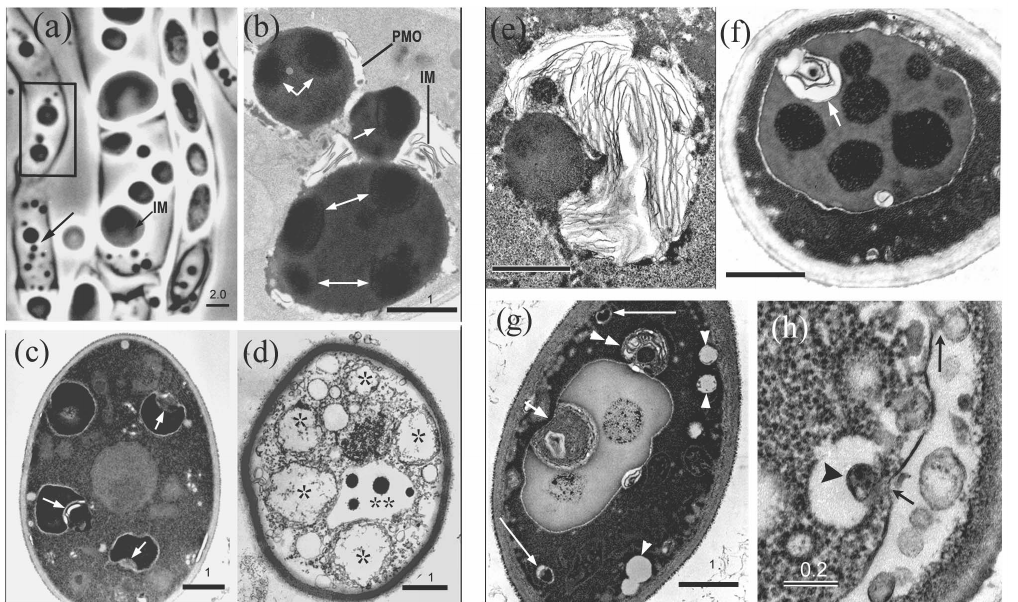
Figure 2. The A.pullulans promycosome organelle: light vs. electron microscopy. (a) Light microscopy; (b–h) electron microscopy. (a) The left hypha contains many presumptive budding PMOs (box and arrow), which express a lipoid body (arrow, center hypha) within the PMO inner membrane (IM). Walled endospores (right hypha) apparently develop within the PMO lipoid body. (b–h) First generation yeast sectioned for EM. (b) Electron-opaque budding organelles require image lightening to reveal internal bodies (white arrows) presumed to be mycosome initials. (c) PMOs are identified by invaginating membranes (arrows) and the electron-lucent space between the outer membrane and the opaque body; (see also b, f and g). (d) PMOs without lipoid content (asterisks) show numerous vesicles between the two membranes. PMOs lacking inner membrane expression may appear as vacuoles that contain electron-opaque bodies (double asterisk). (e) A mycosome-containing PMO with prominent membrane lamellae; see also (g), double arrowheads. (f) A lipoid PMO containing opaque budding mycosome initials; note invaginating membranes (arrow). (g) A lipoid PMO with a membranous infolding (short arrow) and a bud (double arrowhead) containing membrane lamellae and a putative opaque mycosome. Vacuole-like PMOs occur near the cell margin (arrowheads), some containing a putative mycosome initial (long arrows). (h) The fungal plasmalemma may bud to form periplasmic vesicles (long arrow), and may invaginate (short arrow) to form a vacuole-like PMO that contains a vesicle (arrowhead), similar to (g), long arrows. Photos (a and c) from [22] with permission. Bars =(a) 2.0 m m; (b–g) 1.0 m m; (h) 0.2 m